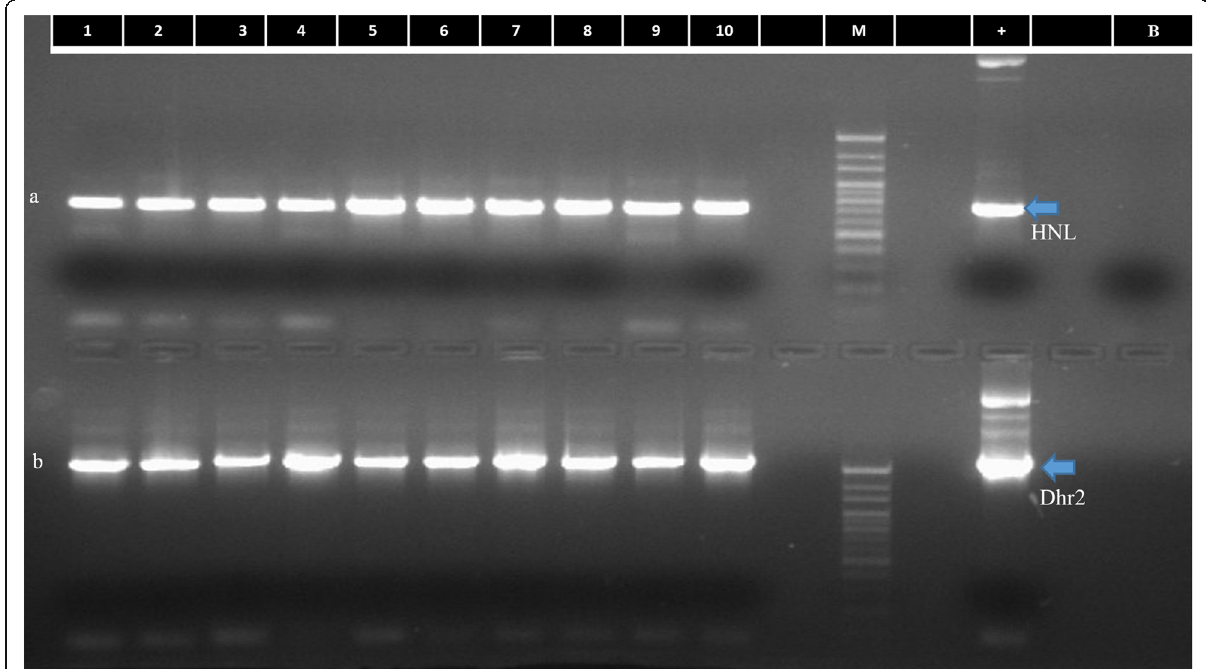
Fig. 5 Colony PCR for confirmation of genes in A. tumefaciens strain LBA4404, a lanes 1~10 pTH2 positive A. tumefaciens colonies, b lanes 1~10 pTD2 positive A. tumefaciens colonies, M: 2 000 bp marker, (+): positive control,